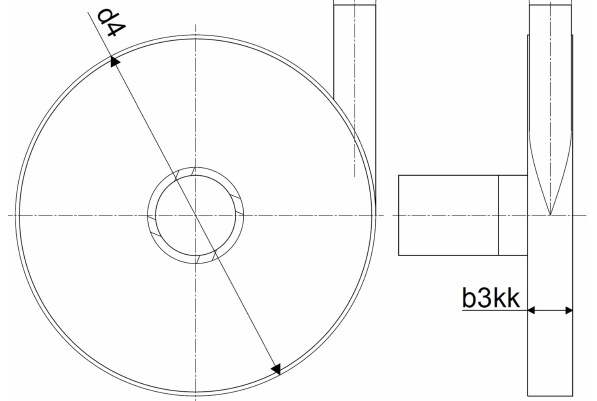
Figure 9: Basic dimensions of the annular type casing